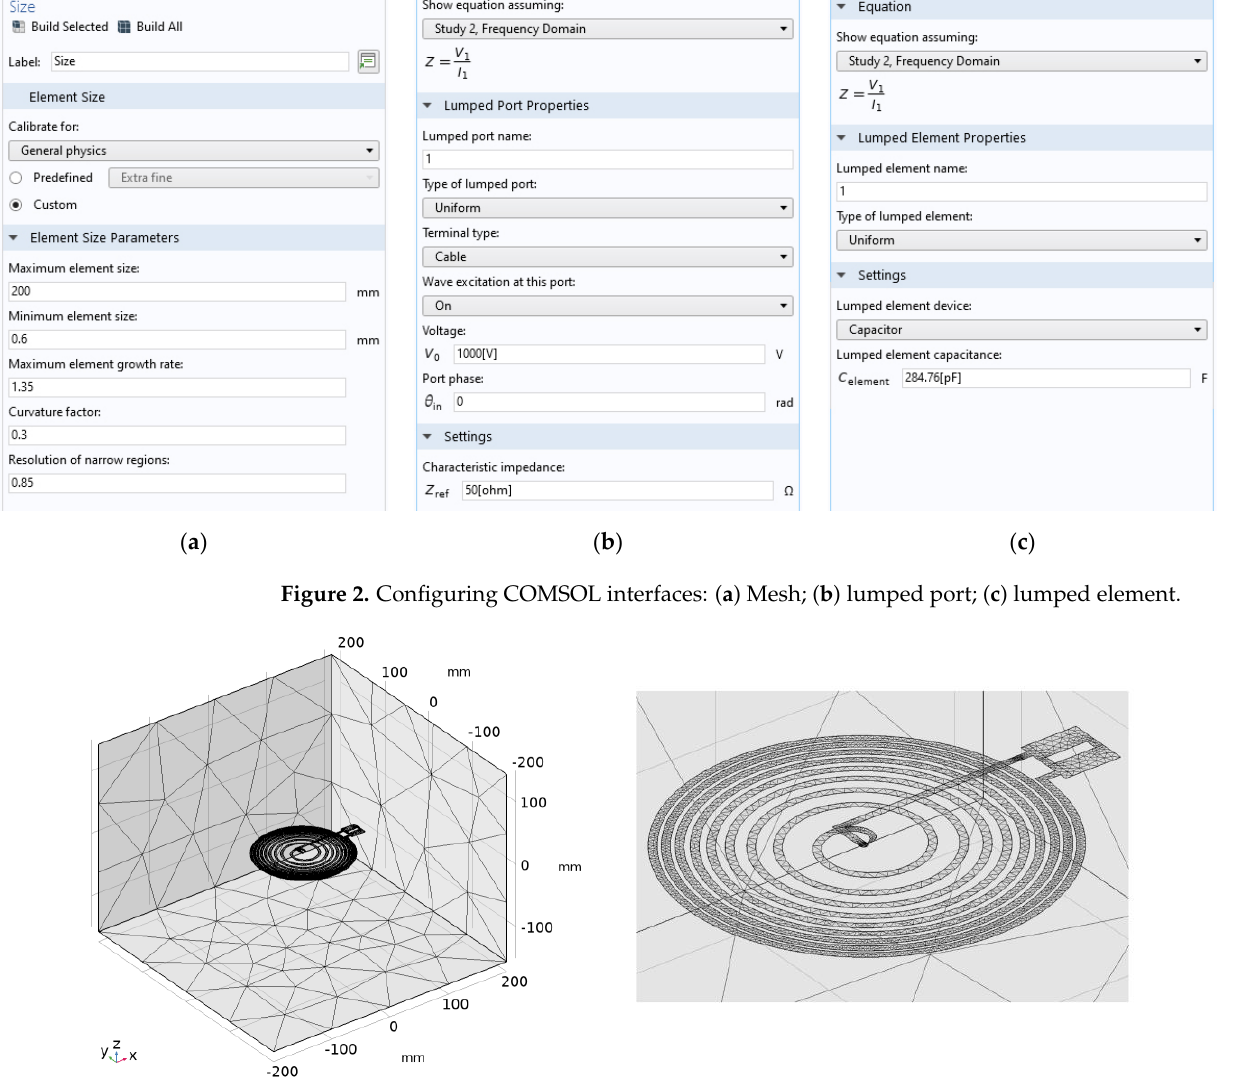
Figure 2. Configuring COMSOL interfaces: ( a ) Mesh; ( b ) lumped port; ( c ) lumped element.